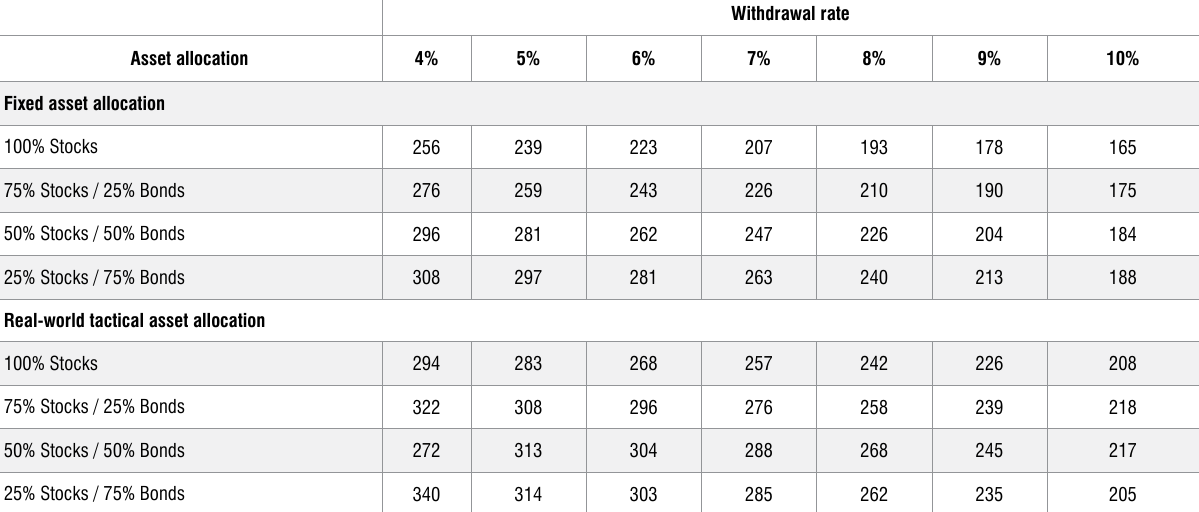
Withdrawal rate